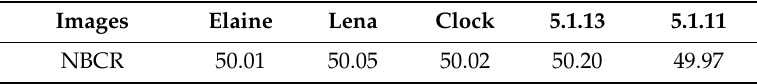
Table 10. Chosen-plaintext attack analysis result.